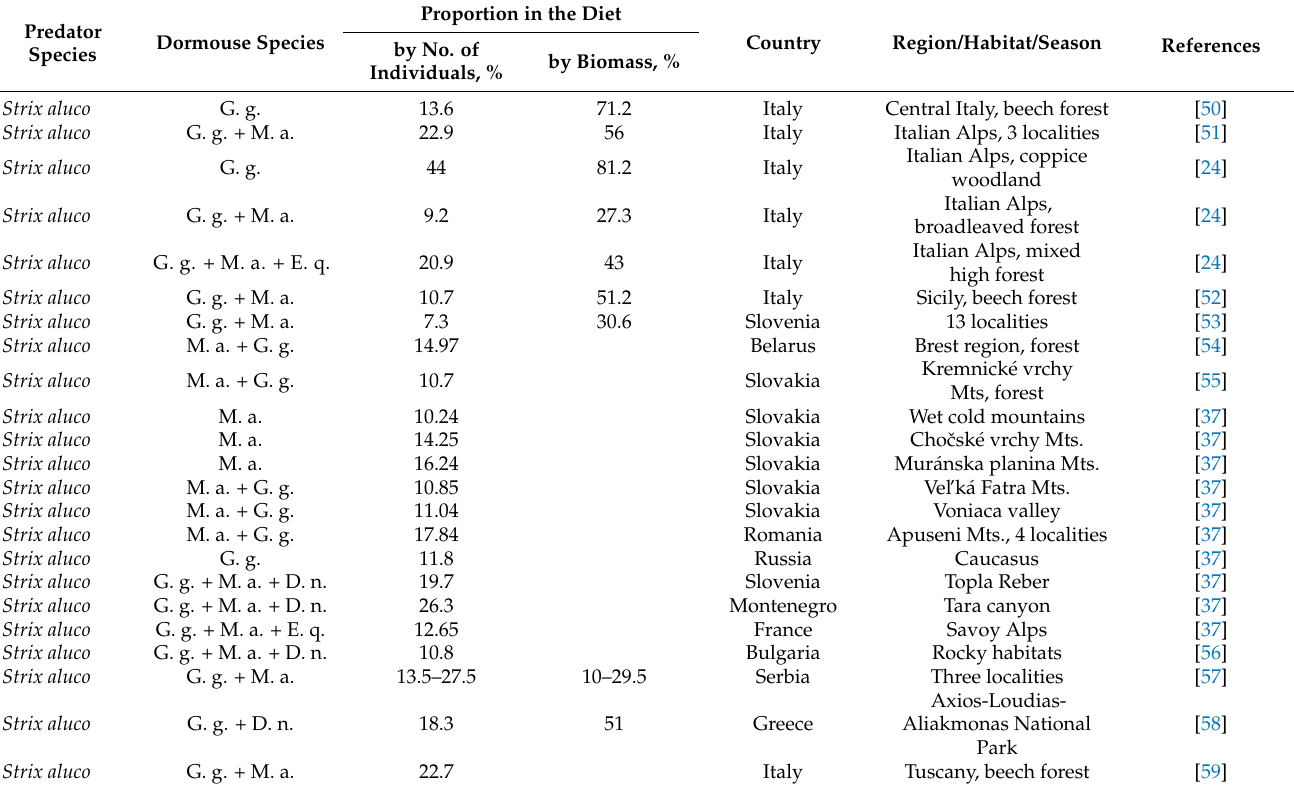
Table 2. Cases where proportion of dormice in the diets of predators reached 10% by number of individuals captured or by biomass consumed. Scientific names of dormouse species are